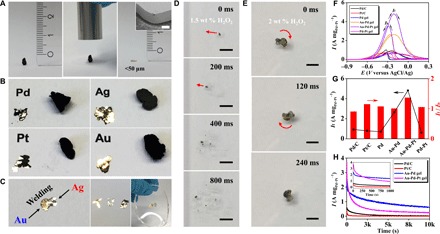
Plasticity and versatile applications of NMAs.(A) A piece of gold aerogel is manually pressed by ca. 98.5%. Scale bar, 30 μm (inset SEM image). (B) Original and compressed NMFs made of Au, Ag, Pd, and Pt. (C) Heterostructured welded Au-Ag aerogel by pressing, the logo “TUD” made by compressing Au, Ag, and Au-Pd-Pt alloy aerogels, and a gold TUD logo encased in PDMS. (D and E) Self-propelling behavior of (D) Ag aerogel and (E) compressed Au-Ag aerogel in H2O2 solution. wt. %, weight %. Scale bars, 5 mm. (F to H) Ethanol electro-oxidation performance, (F) cyclic voltammetry curves, (G) summarized If and If/Ib, and (H) chronoamperometry curves of different catalysts. (Photo credit: Ran Du.)